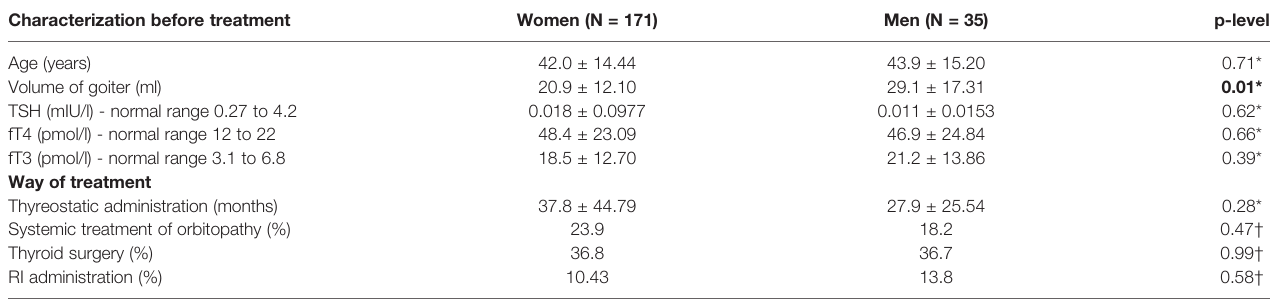
TABLE 1 | Clinical characterization of the whole cohort of GD